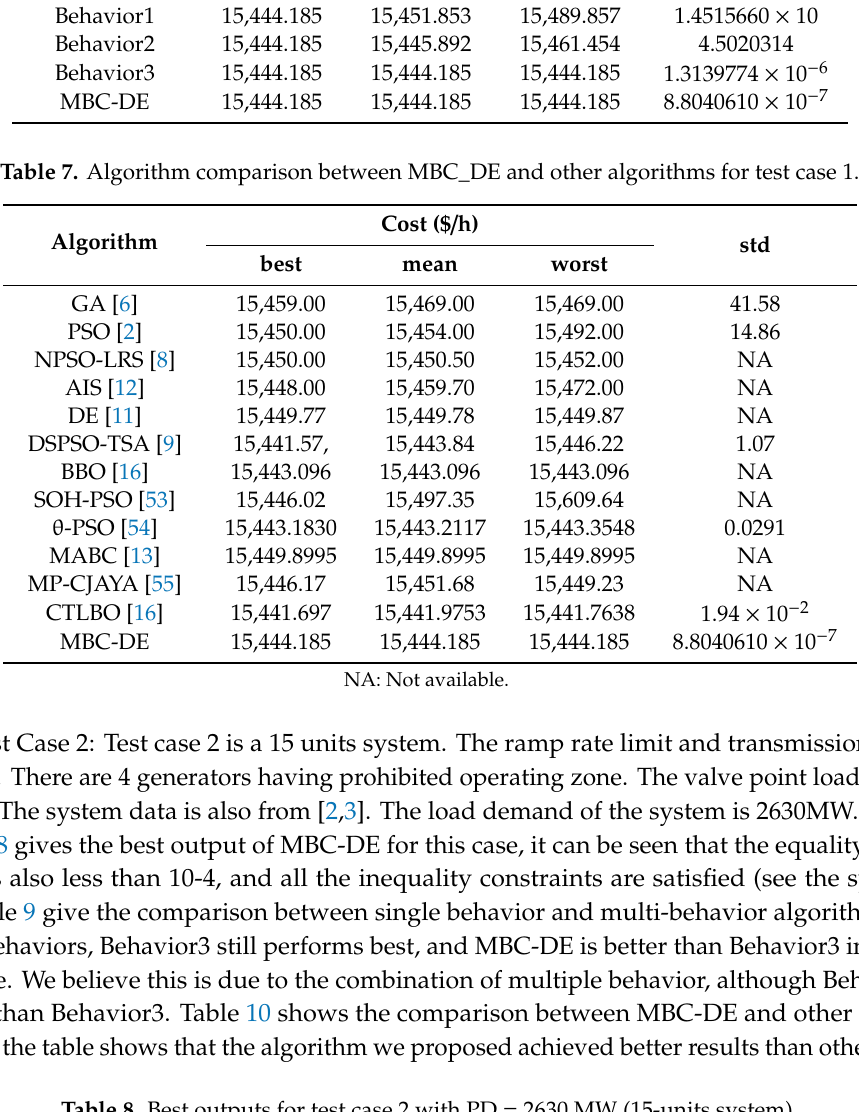
Table 8. Best outputs for test case 2 with PD = 2630 MW (15-units